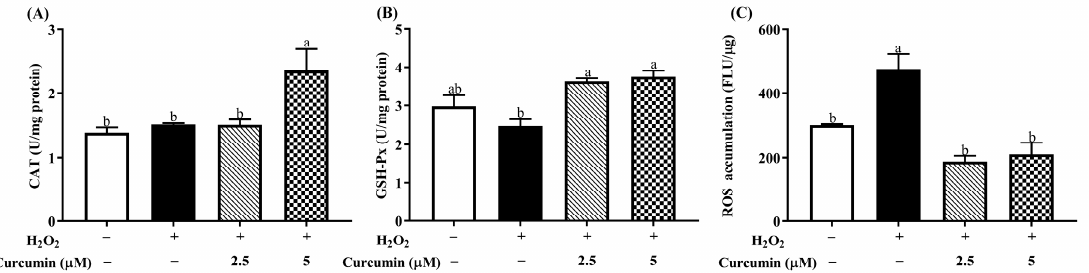
Figure 2. Effect of curcumin on the activity of antioxidant enzymes and ROS generation. Cells were pretreated with 2.5 or 5 µ M curcumin for 24 h, and then incubated with 400 µ M H 2 O 2 for another 24 h. The activity of cellular CAT ( A ), GSH-Px ( B ) and ROS accumulation ( C ) were measured. ROS production was determined using the DCFH-DA assay. Data are presented as the mean ± SEM ( n = 3). a, b Means with different letters are significantly different ( p < 0.05).